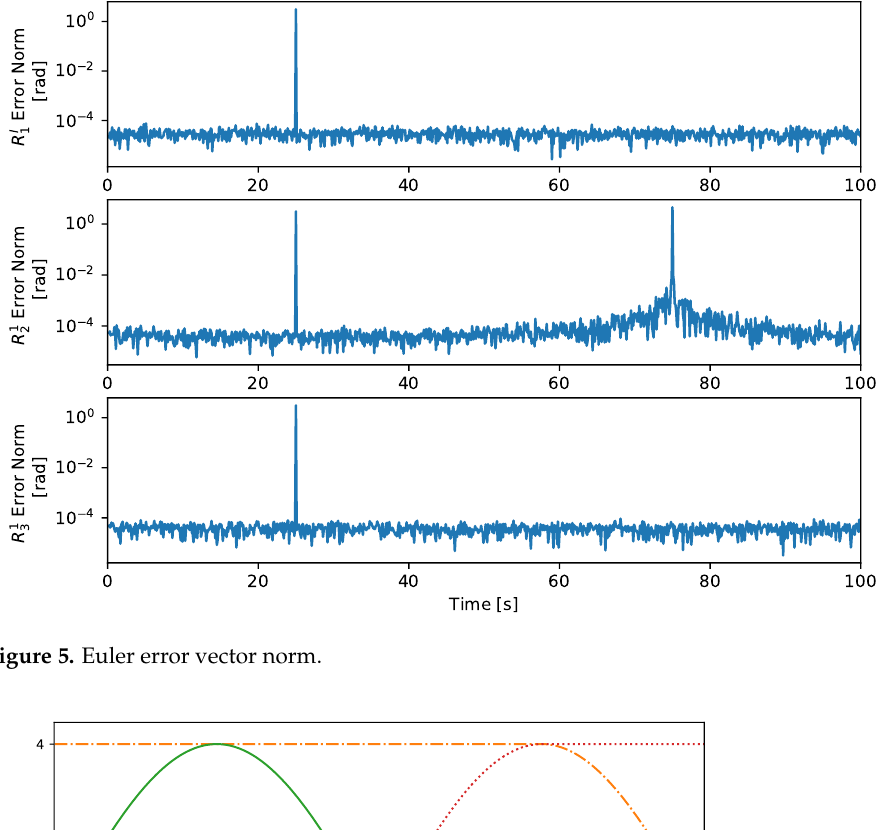
Figure 5. Euler error vector norm.